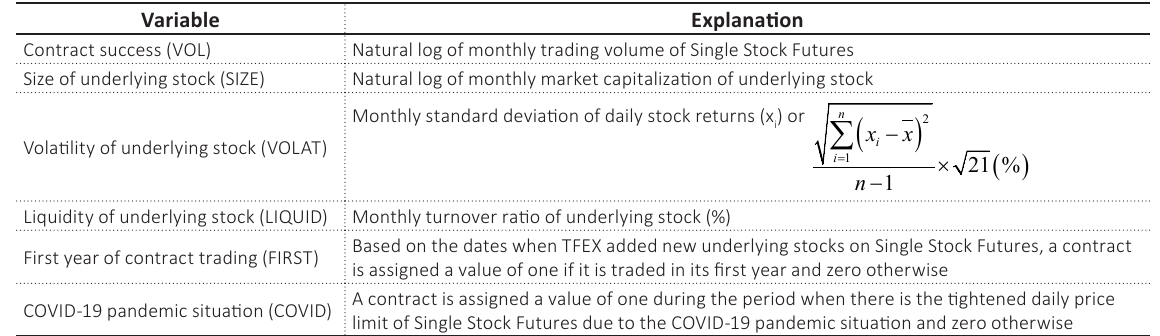
First year of contract trading